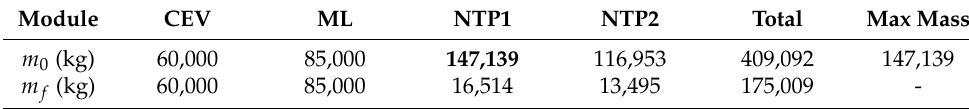
Table 14. Mass scale of Architecture-6.